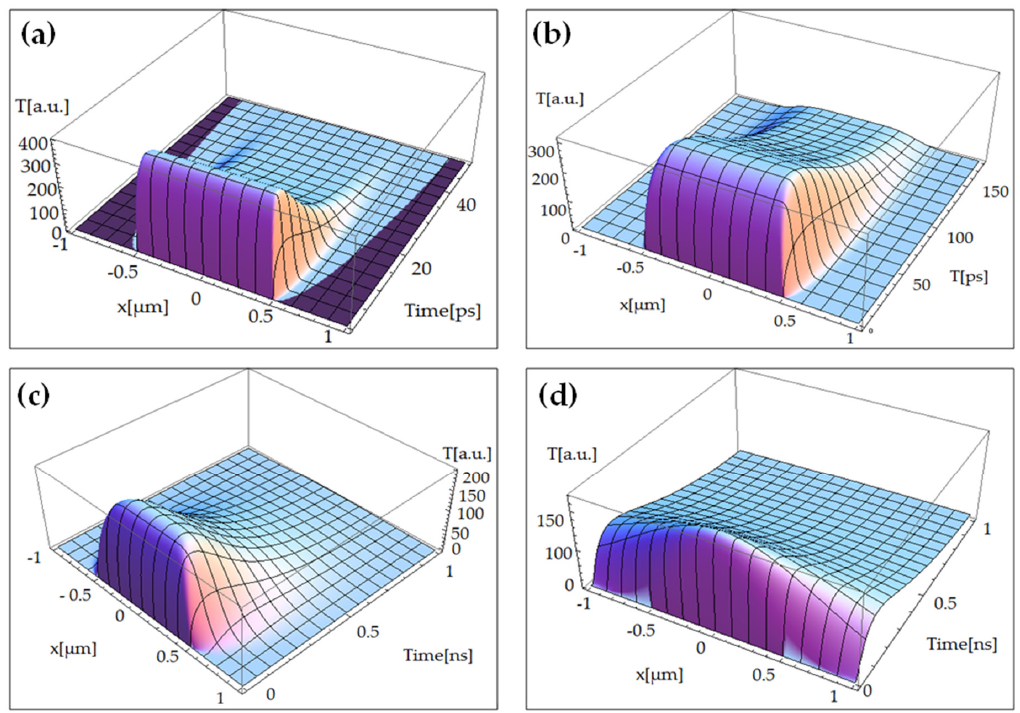
Figure 2. Temperatures field versus current coondinate and time during flash laser irradiation of a single ‐ layer graphene of the ( a ) transverse optical phonons (TO), ( b ) longitudinal optical phonons (LO), ( c ) longitudinal acoustic phonons (LA), and ( d ) transverse acoustic phonons (TA) phonons. The output of current model is in good agreement with the one presented in Refs. [7,20]. The observation from Ref. [7] that electrons cool ‐ down faster than all kinds of phonons (not only optical ones) is also confirmed by current simulation. It is due to similar reasons, related to K e and C e values,